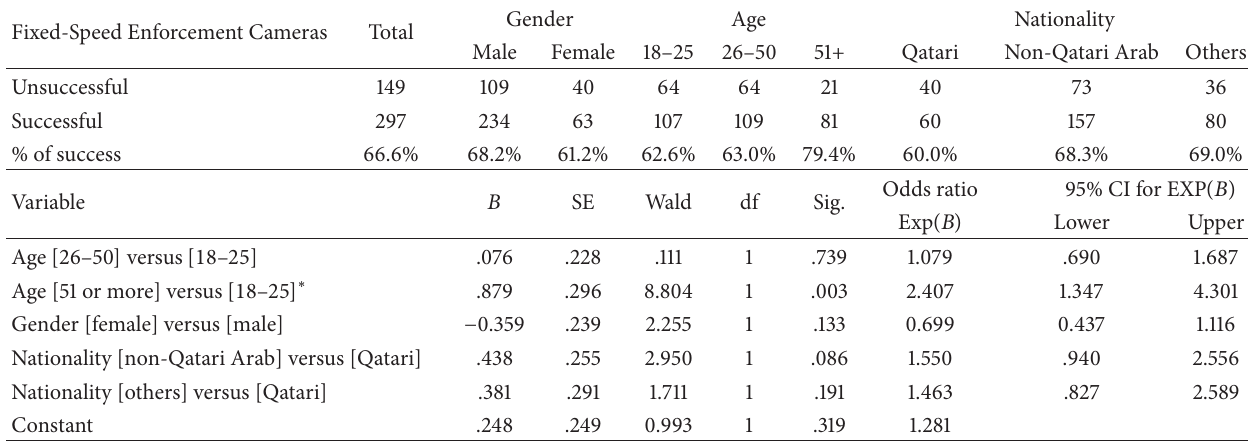
Table 5: Reported success and logistic model results for the fixed-speed enforcement cameras